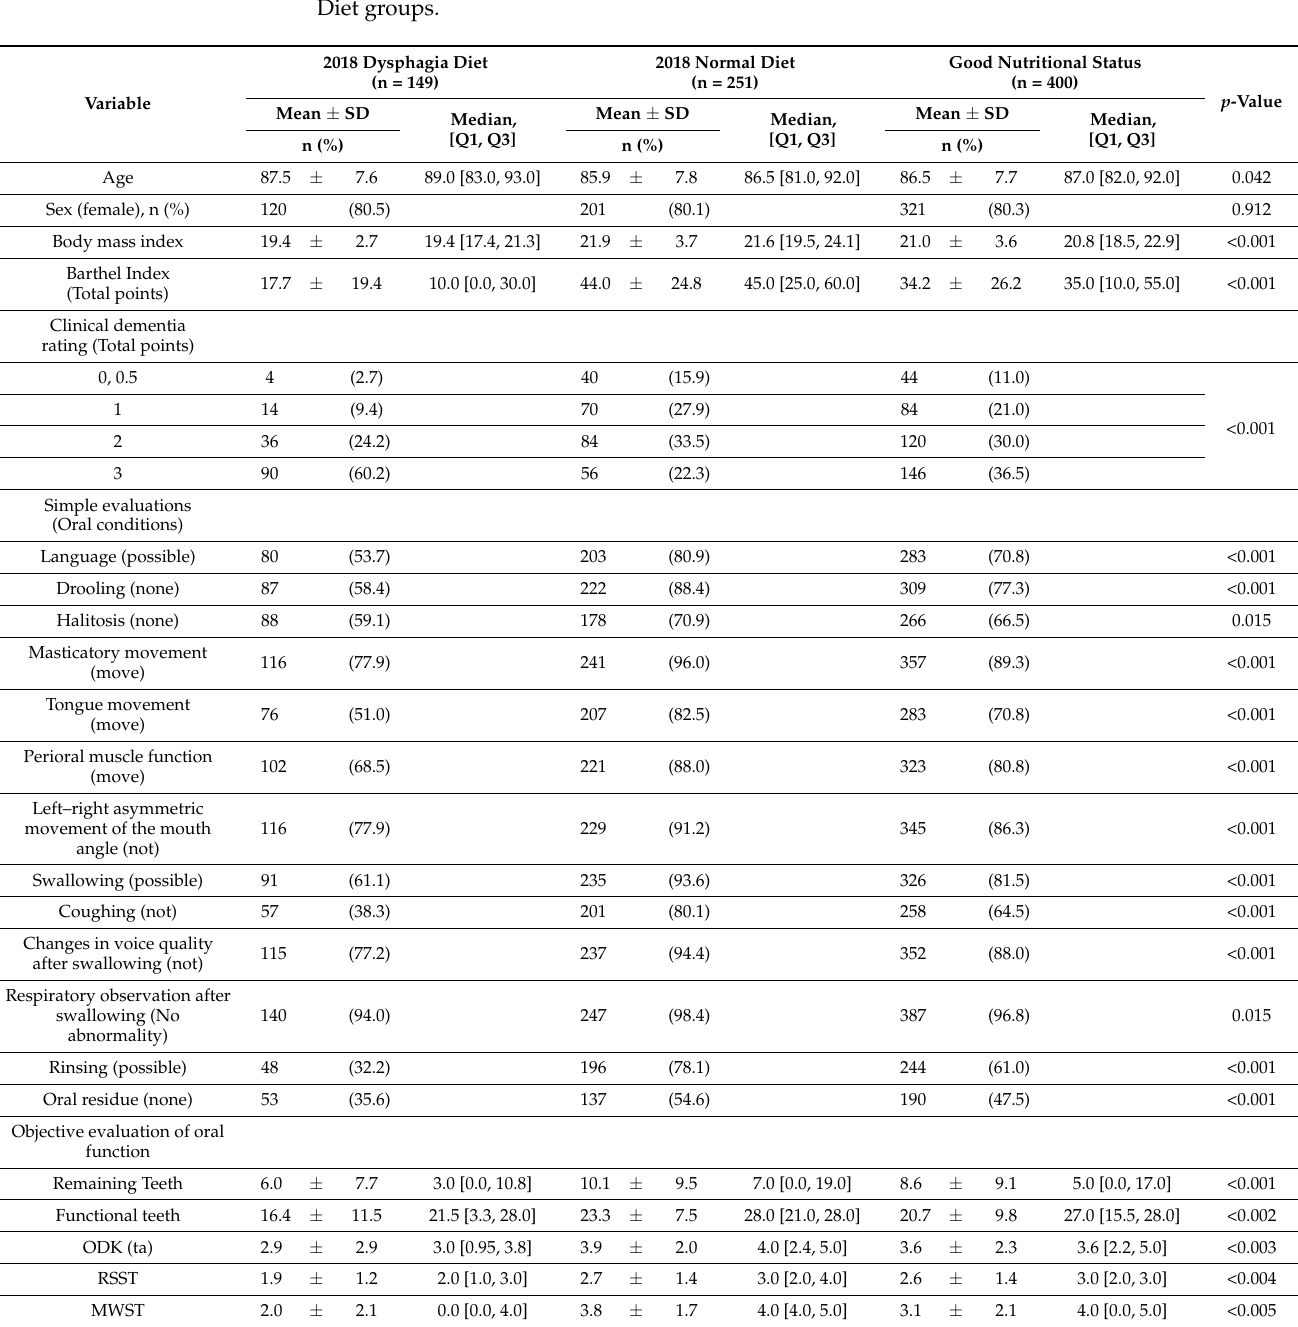
Table 1. Comparison of characteristics of the study participants in the 2018 Normal and Dysphagic Diet